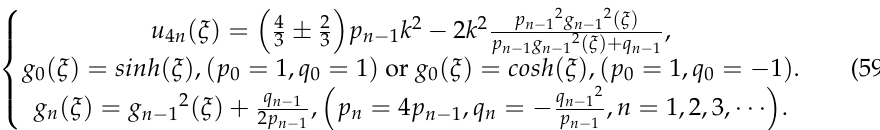
Figure 3. Evolution of solitary waves with n in u 3 n when k = 1: ( a ) n = 1, ( b ) n = 2, ( c ) n = 3, and ( d ) n = 4 .